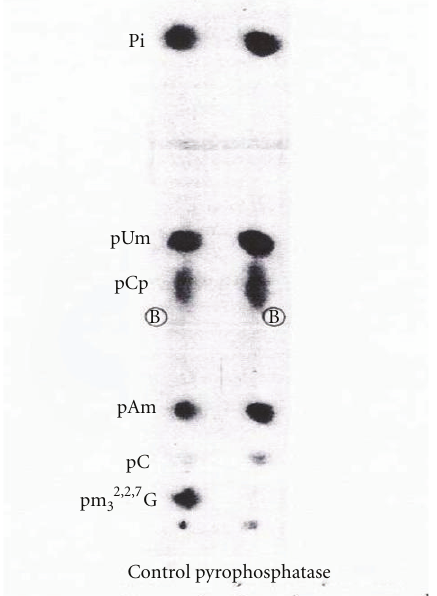
Figure 28: The susceptibility of 5 (cid:2) cap to pyrophosphatase [12]. The [ 32 P]-labeled 5 (cid:2) oligonucleotide obtained from U2 RNA by RNase A was digested with pyrophosphatase and base composition was analyzed by snake venom phosphodiesterase digestion. This digestion released m 32,2,7 G from the 5 (cid:2) fragment indicating that m 32,2,7 G is linked by a pyrophosphate linkage.